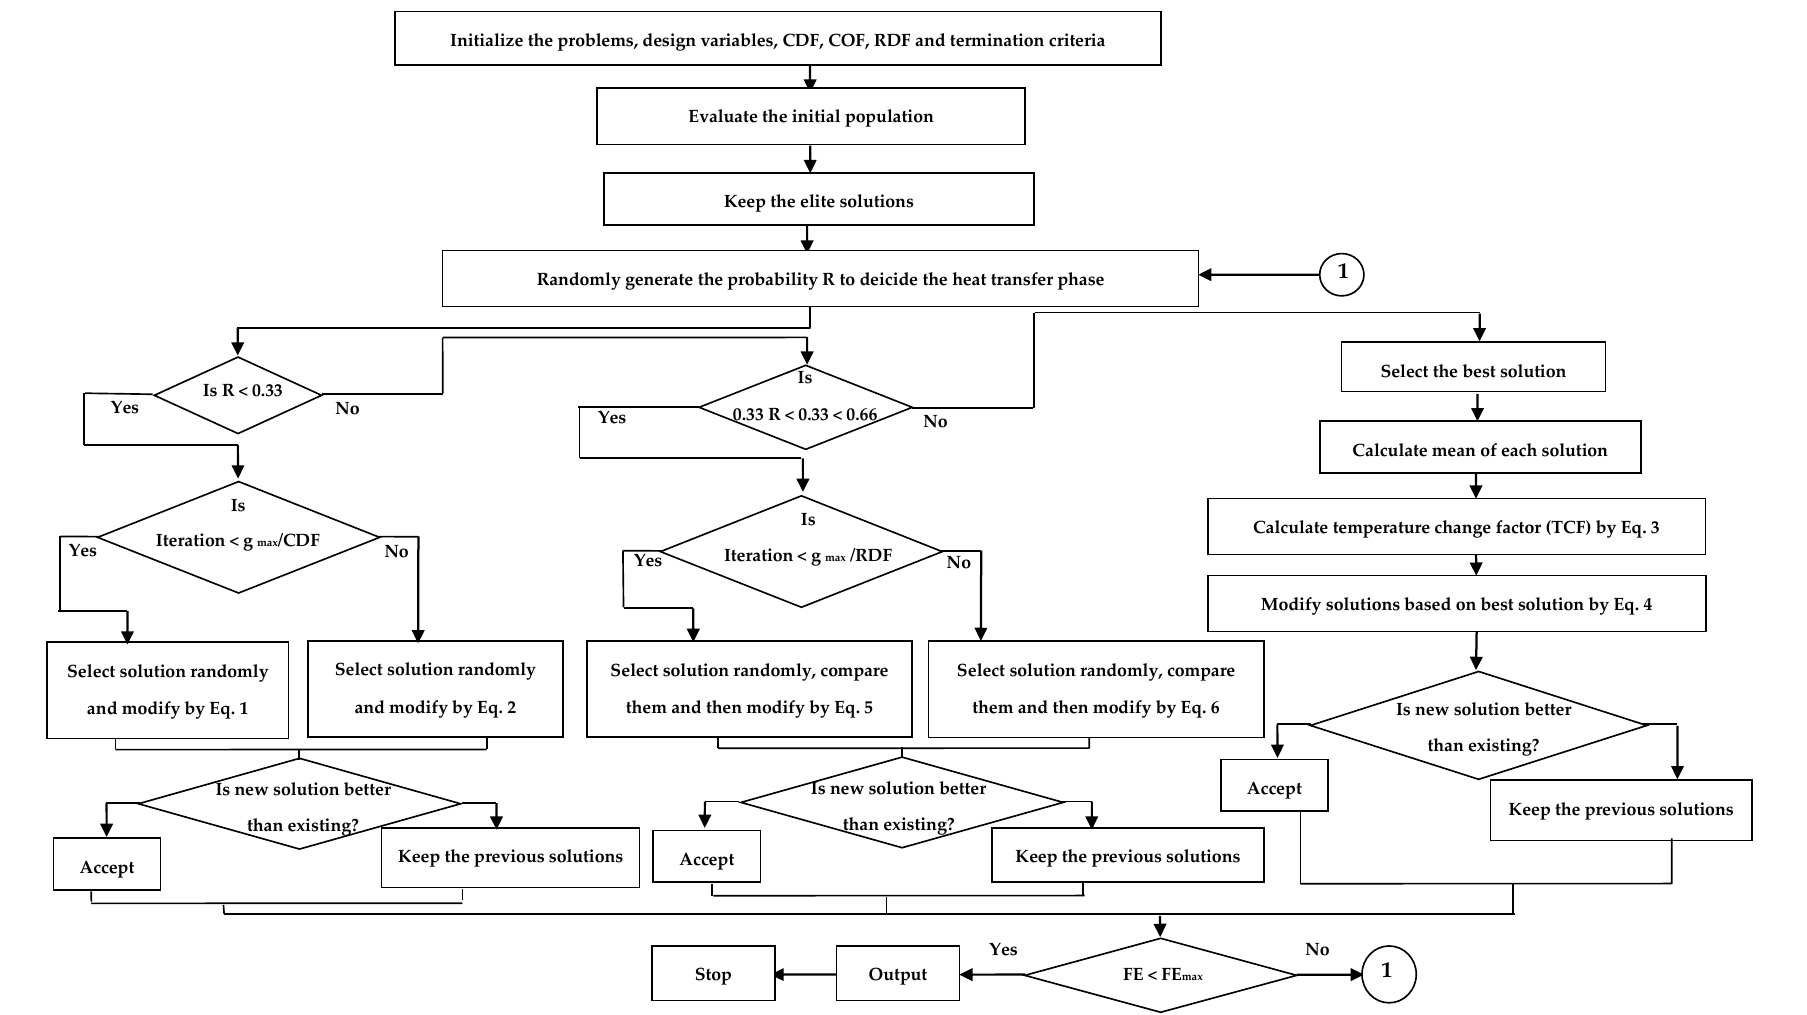
Figure 4. HTS algorithm methodology [37].